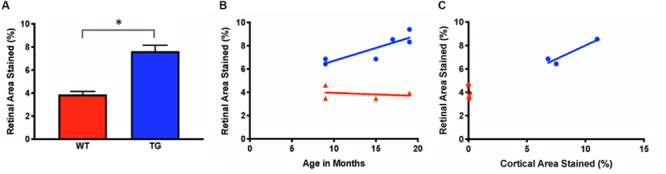
Measurements of ex vivo retinal Aβ immunofluorescence in Tg and WT retina. (A)
Ex vivo retinal Aβ immunoreactivity was significantly higher in Tg (blue) than WT (red) (Tg: 7.63% ± 0.52, N = 6; WT: 3.87% ± 0.26, N = 4; p < 0.05; Two-tailed Mann Whitney U test). (B) Retinal Aβ increased with age in the Tg (blue), but less so in the WT (red) (r2 = 0.74, vs. r2 = 0.06, p = 0.76. (C) Cortical and retinal ex vivo labeling correlated better in Tg (blue) than WT (red) mice (Tg: r2 = 0.88, N = 3, p = 0.26; WT: r2 = 0.43, N = 3, p = 0.55). *Denotes significance.